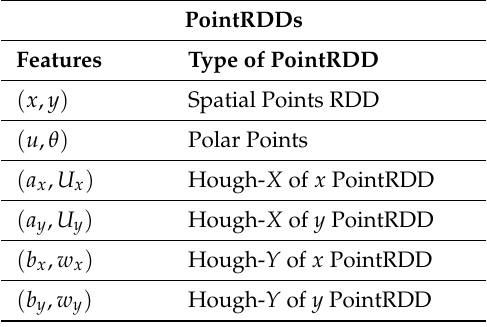
Table 4. The Different Types of Point Resilient Distributed Dataset (RDDs) According to Selected